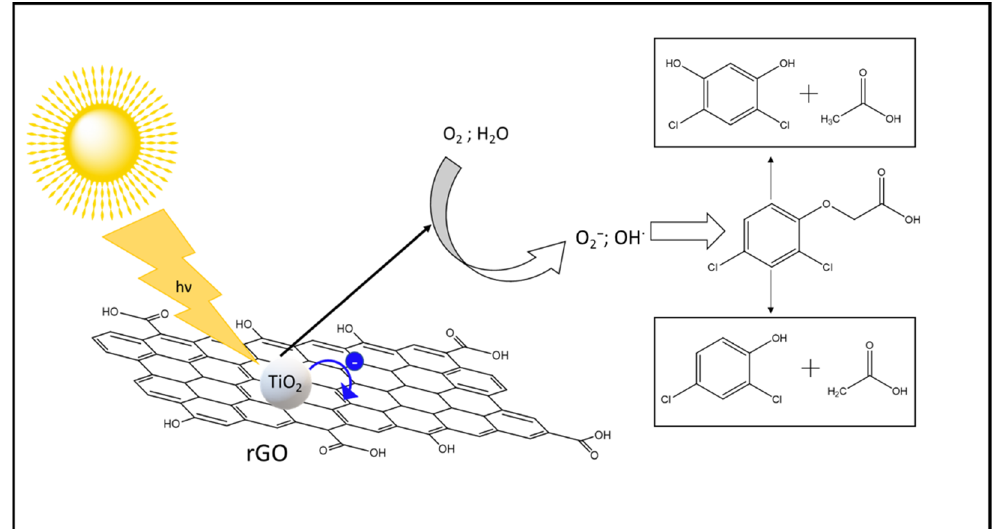
Figure 8. Proposed photocatalytic mechanism.